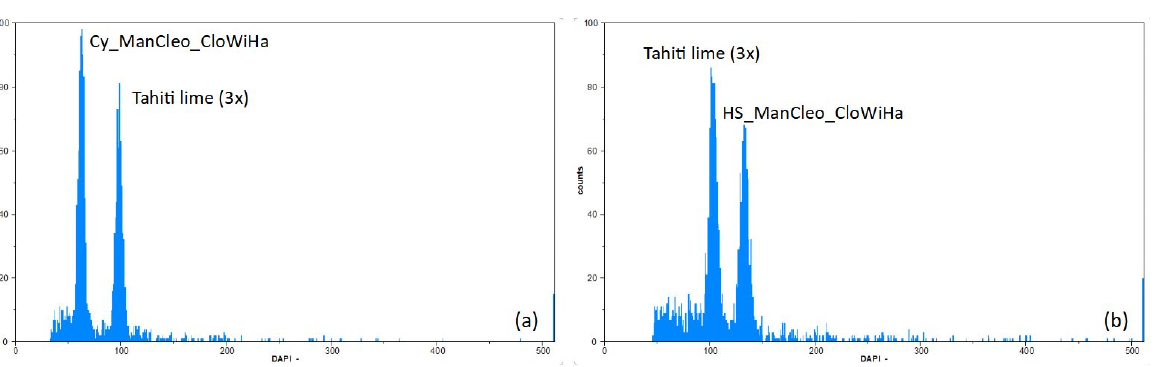
Figure 2. Identification of near diploid and tetraploid plants by flow cytometry in the Cleopatra mandarin + Winter Haven combination using the triploid Tahiti lime as internal control: ( a ) diploid like plant, ( b ) tetraploid like